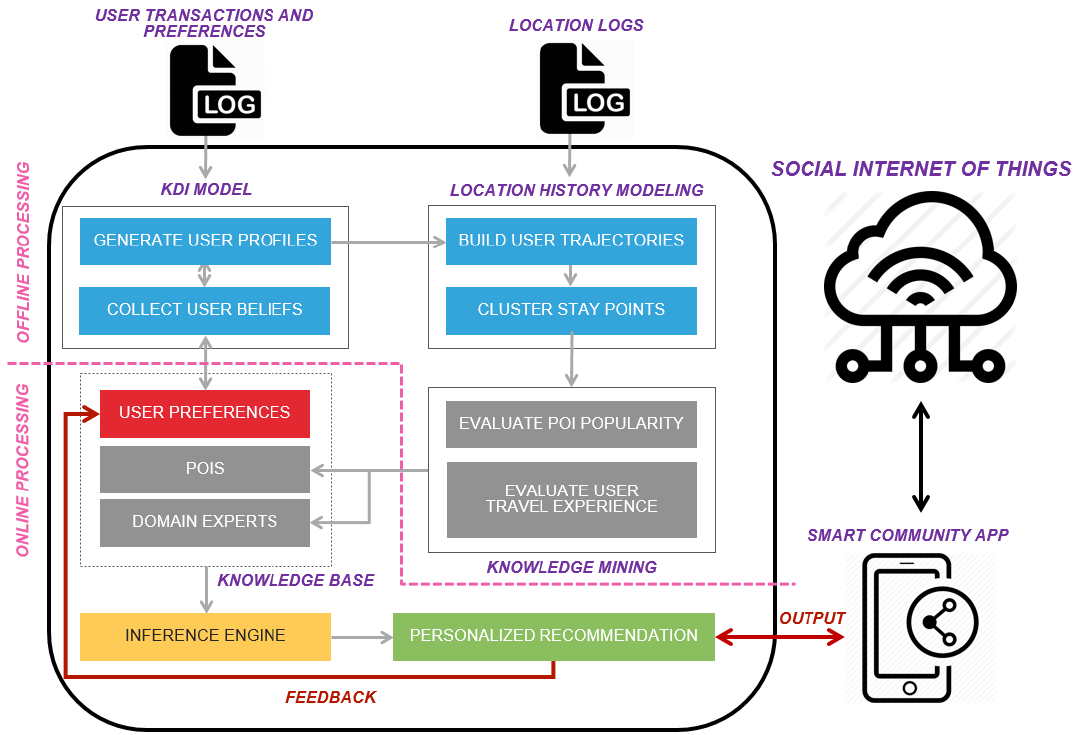
Figure 7. Proposed personalized recommendation framework (an extension of our work in [23]).